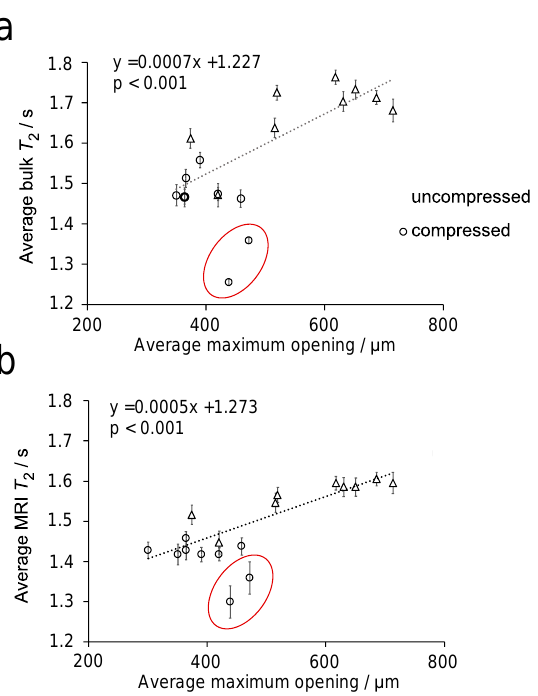
Figure 7. Plot of the average maximum opening vs. bulk T 2 MR relaxation time ( a ) and average T 2 relaxation time determined from T 2 relaxation MR maps ( b ) for 7° dH water in uncompressed and compressed sponge plugs. The dotted lines are a linear fit of the data. Two outlying samples are circled in each plot.